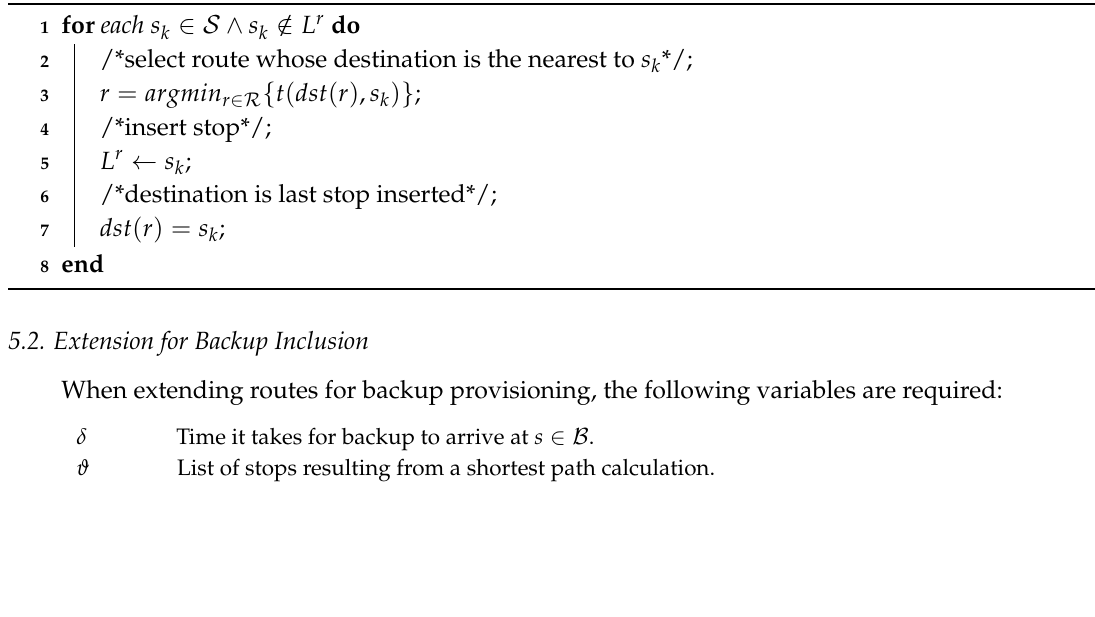
Algorithm 4: Procedure for the insertion of the remaining